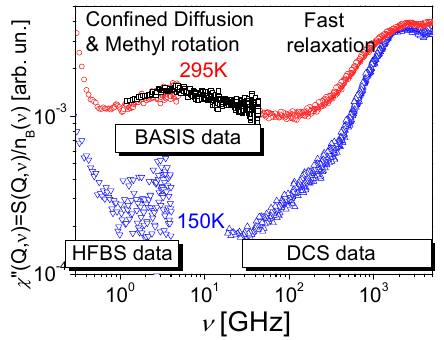
Fig. 14 . Susceptibility spectra of protein lysozyme obtained by combination of data from 3 spectrometers, time-of-flight DCS (NIST), backscattering BASIS (SNS) and backscattering HFBS (NIST). Reprinted with permission from [86]. Copyright 2015 The Royal Society of